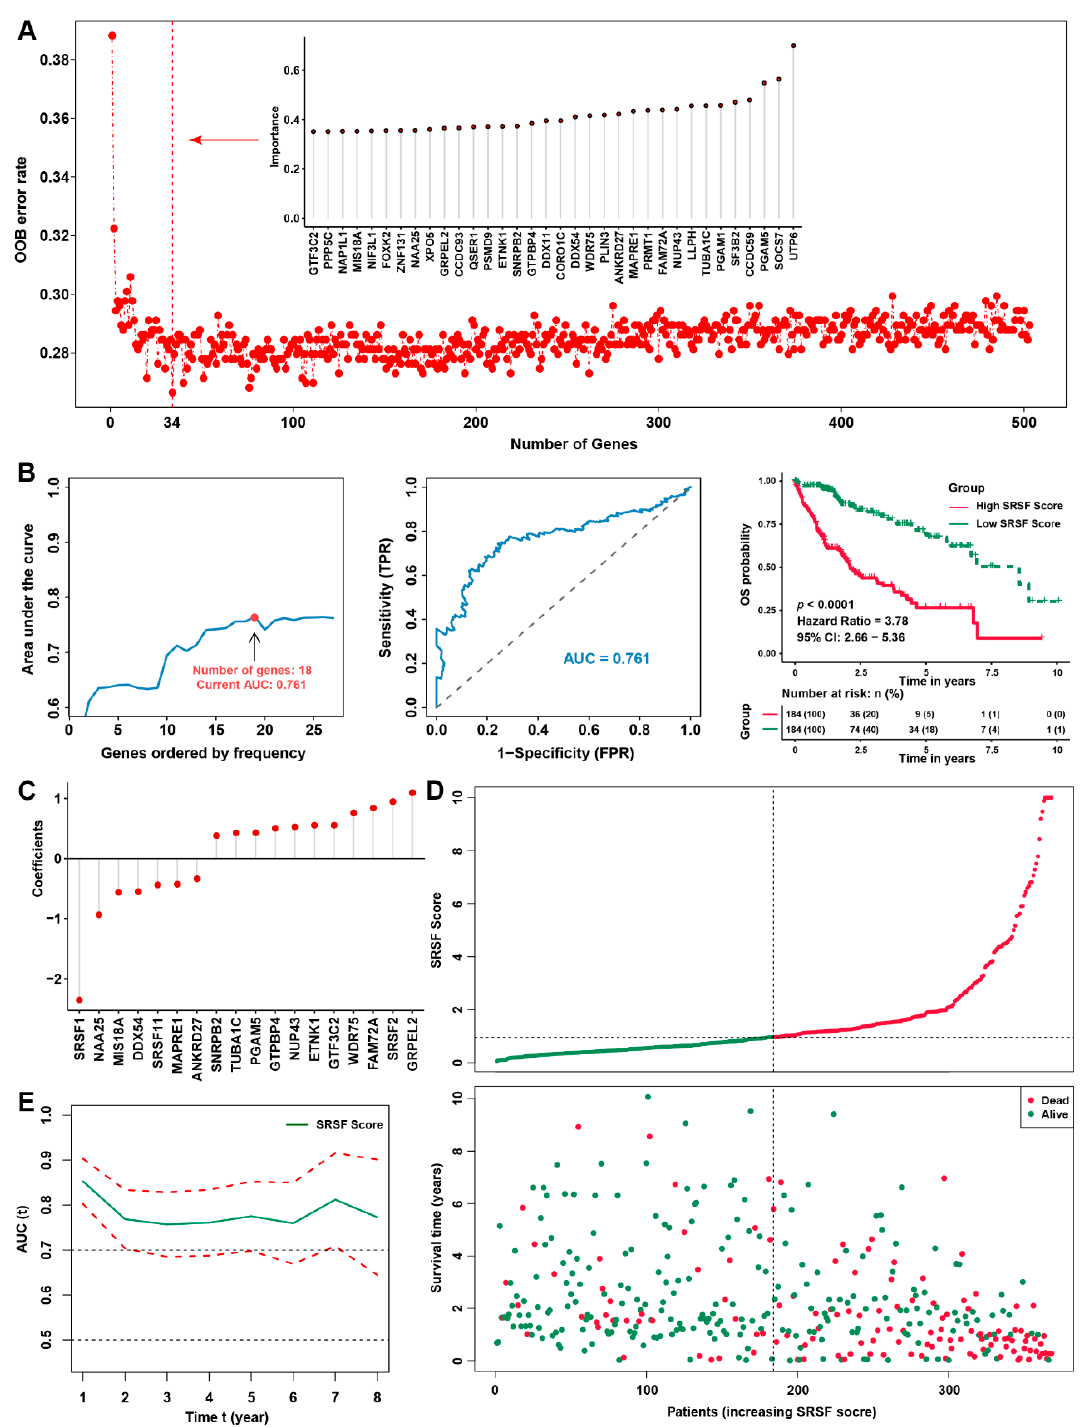
Figure 4. Construction of the SRSF score and the validation of its prognostic predictive value. ( A ) The relative importance of each gene of the SRSF family-based signature was calculated by random survival forest analysis, and the 34 most critical genes are shown. ( B ) Iteration LASSO analysis constructed an SRSF score with 18 genes. The AUC value was 0.761, and the survival curve for the SRSF score is shown in the right panel. ( C ) Coefficients of 18 genes involved in the SRSF score. ( D ) The tendency for the survival state of each HCC patient to change with the SRSF score. ( E ) The time-dependent AUC values of the SRSF score for the prediction of 1- to 8-year survival rates in the TCGA-LIHC dataset.